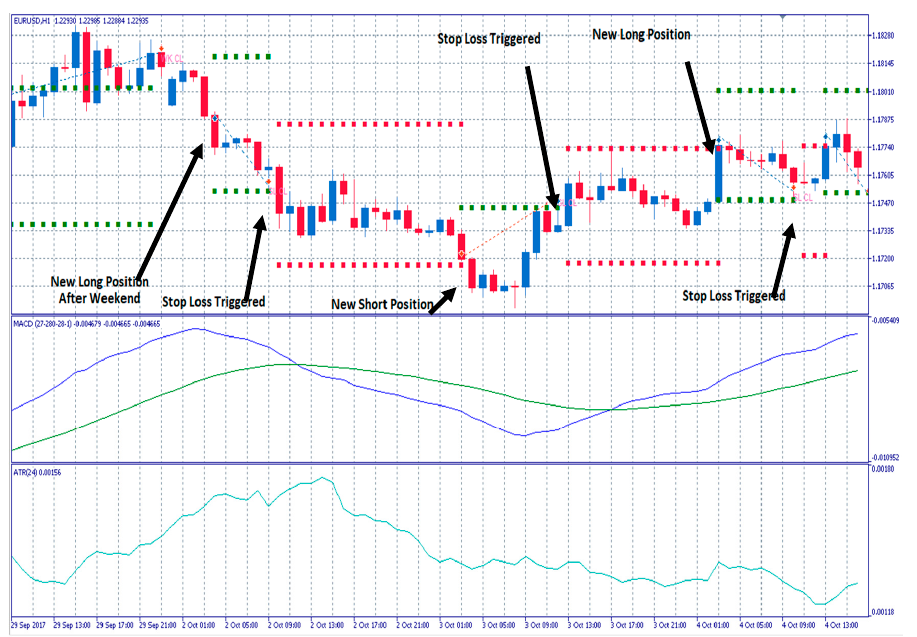
Figure 3. A segment from an MACD Expert Advisor’s trading on EURUSD. The green dots on the price chart indicate the ±2 × ATR(24) Stop Loss barrier after opening a new position and the red dots indicate the ±2 × ATR(24) barrier for new positions prevention after Stop Loss.